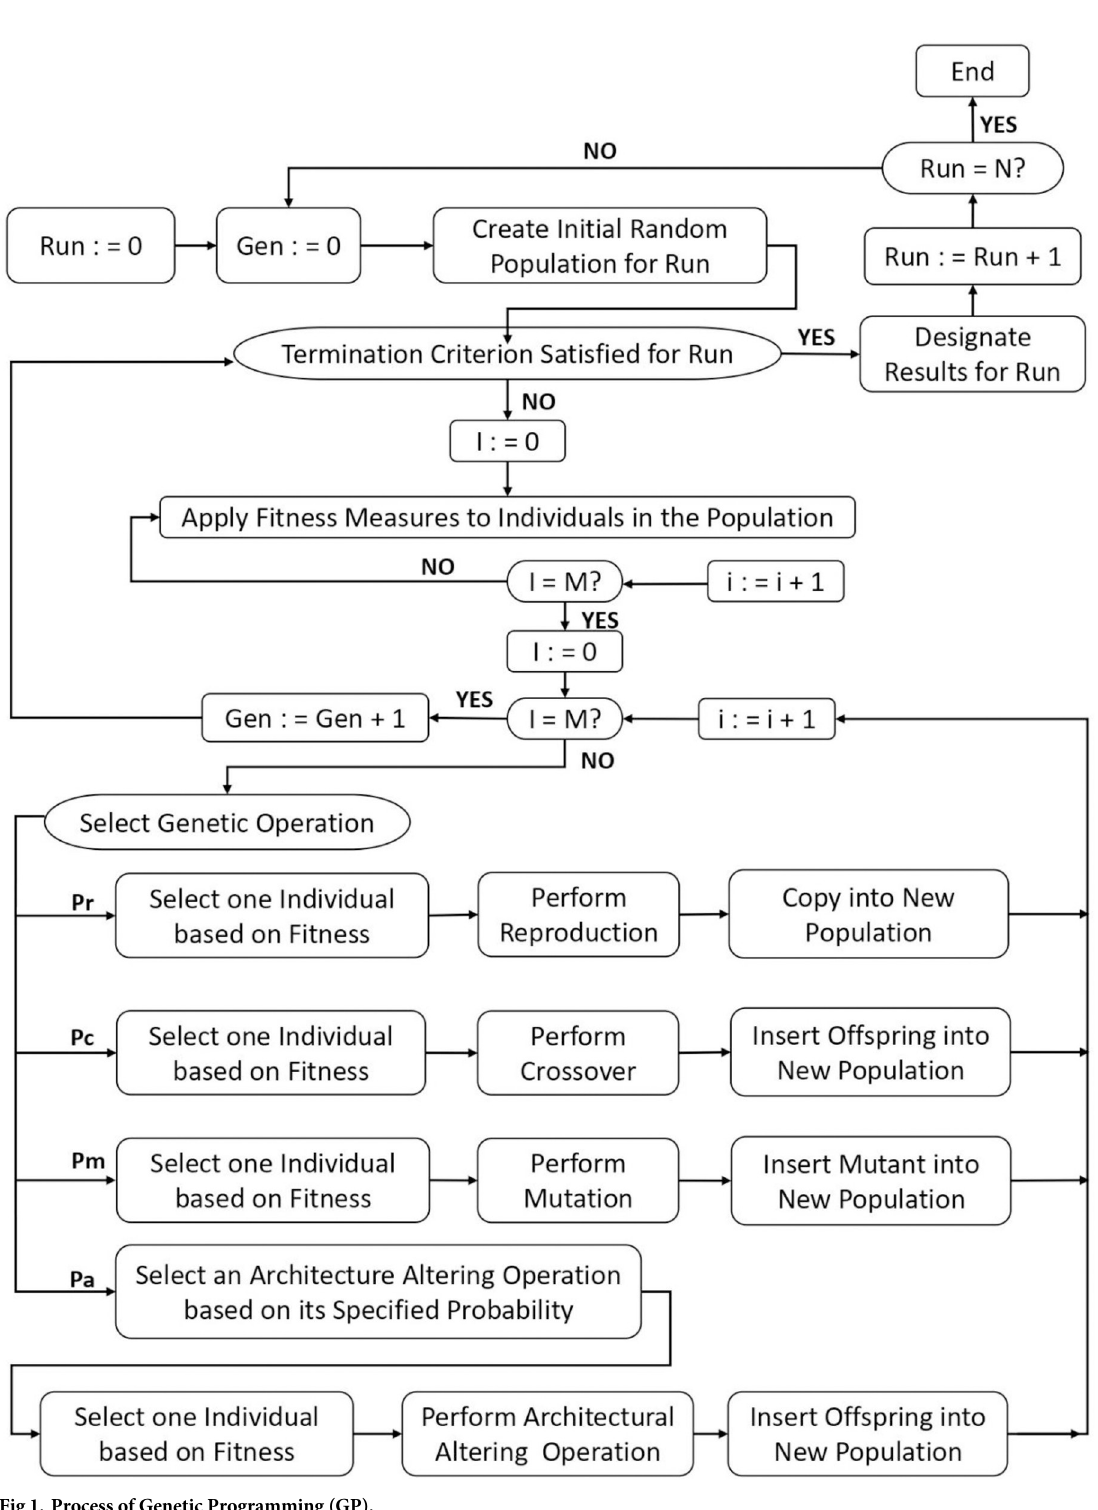
Fig 1. Process of Genetic Programming (GP).